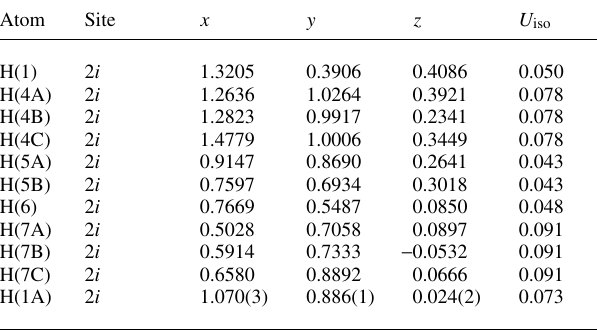
Table 2. Atomic coordinates and displacement parameters (in Å 2 )